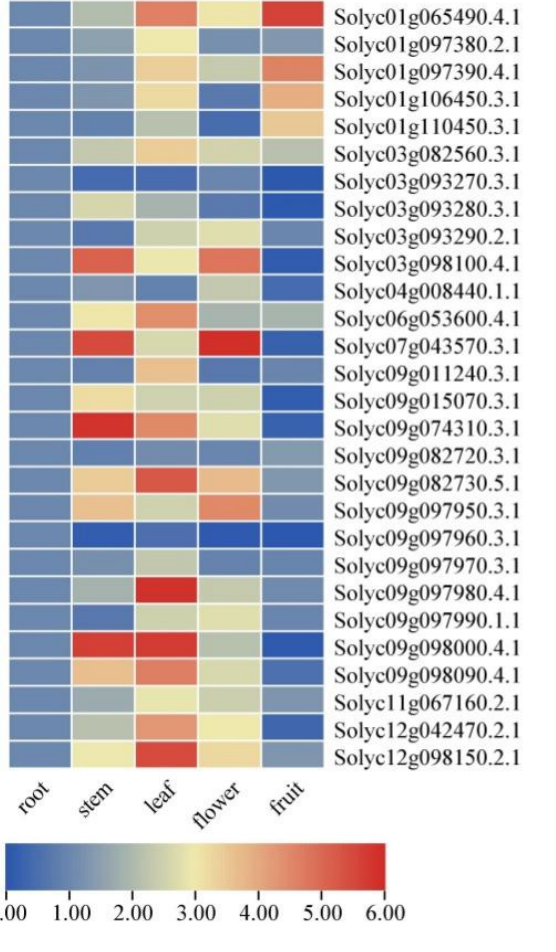
Figure 7. The expression levels of SlAKR genes in various organs of Solanum lycopersicum.